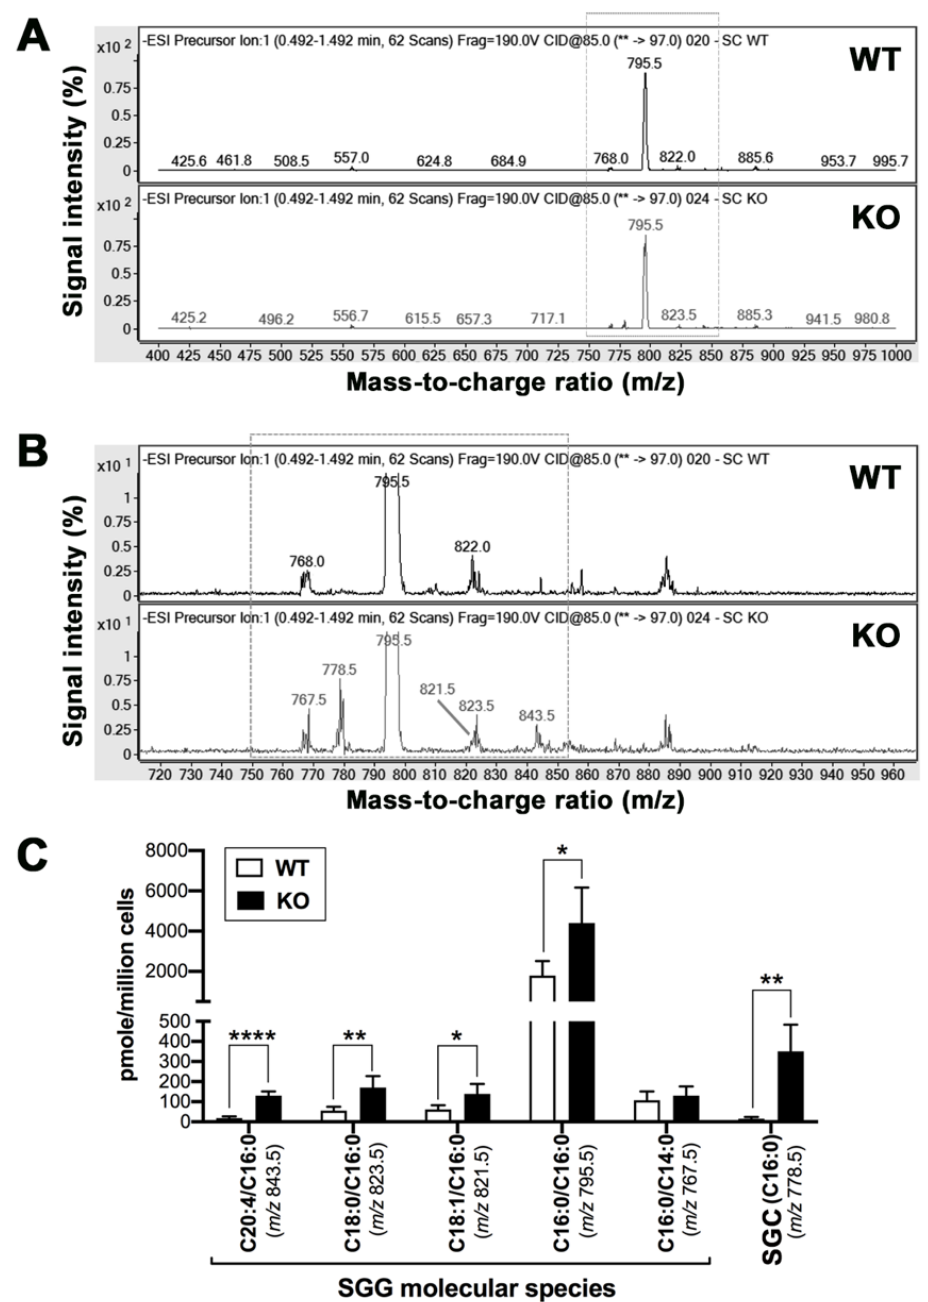
Figure 3. ESI/MS-MS spectra from precursor ion scanning of m / z 97 (sulfate group) showing major sulfolipids in Sertoli cells from 8-month-old wild type (WT) and Arsa KO mice. ( A ) Representative mass spectra of one out of four sets of WT and KO samples were shown. Note that SGG (C16:0/C16:0) with m / z 795.5 was the most abundant sulfolipid in both WT and KO Sertoli cells. ( B ) Magnified view of the mass spectra in the range of m / z 720-960 showing the presence of three SGG molecular species (C16:0/C14:0 with m / z 768.0/767.5; C18:1/C16:0 with m / z 821.5/822.0; C18:0/C16:0 with m / z 823.5) in both WT and KO Sertoli cells, as well as the selective presence of another SGG molecular species, (C20:4/C16:0, m / z 843.5), and a sulfatide SGC (C16:0) with m / z 778.5 in the KO sample. ( C ) Comparative amounts of various SGG molecular species and sulfatide (SGC (C16:0)), as determined by tandem MS coupled with MRM, in WT and Arsa KO Sertoli cells. Results shown are from four replicate experiments. *, **, **** denote p < 0.05, 0.01 and 0.0001,